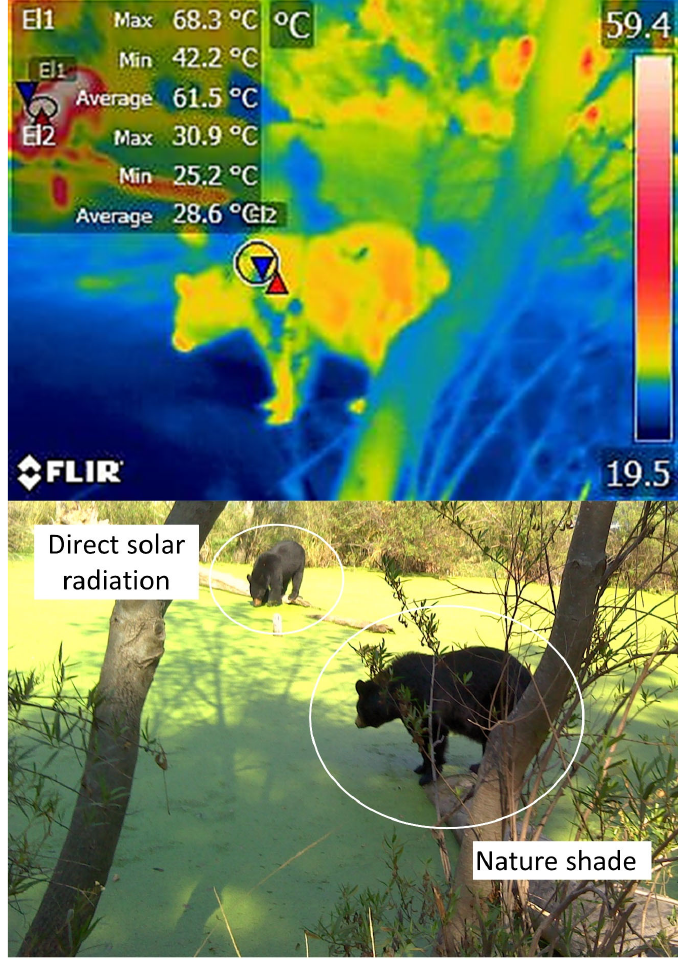
Figure 13. Comparison of the surface temperature in the dorsal area of two American black bears ( Ursus americanus ). Upon assessing the influence of shaded areas on the thermal state of these animals, it is clear that the bear standing under the shade (right side of the thermogram) has an average dorsal superficial temperature of 28.6 °C. In comparison, the individual exposed to direct solar radiation recorded an average value of 61.5 °C. The difference of 32.9 °C between these two animals is an important trait that needs to be considered when designing enclosures for wildlife under human care (Radiometric images and photographs by the authors).